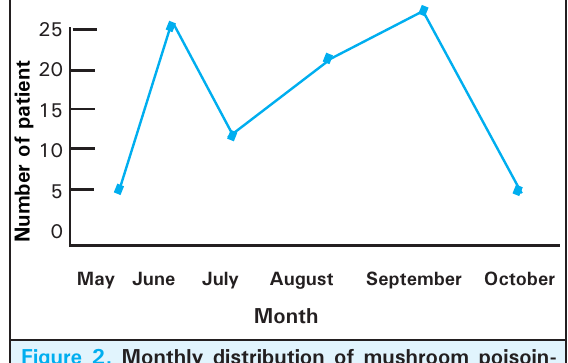
Figure 2. Monthly distribution of mushroom poisoin-